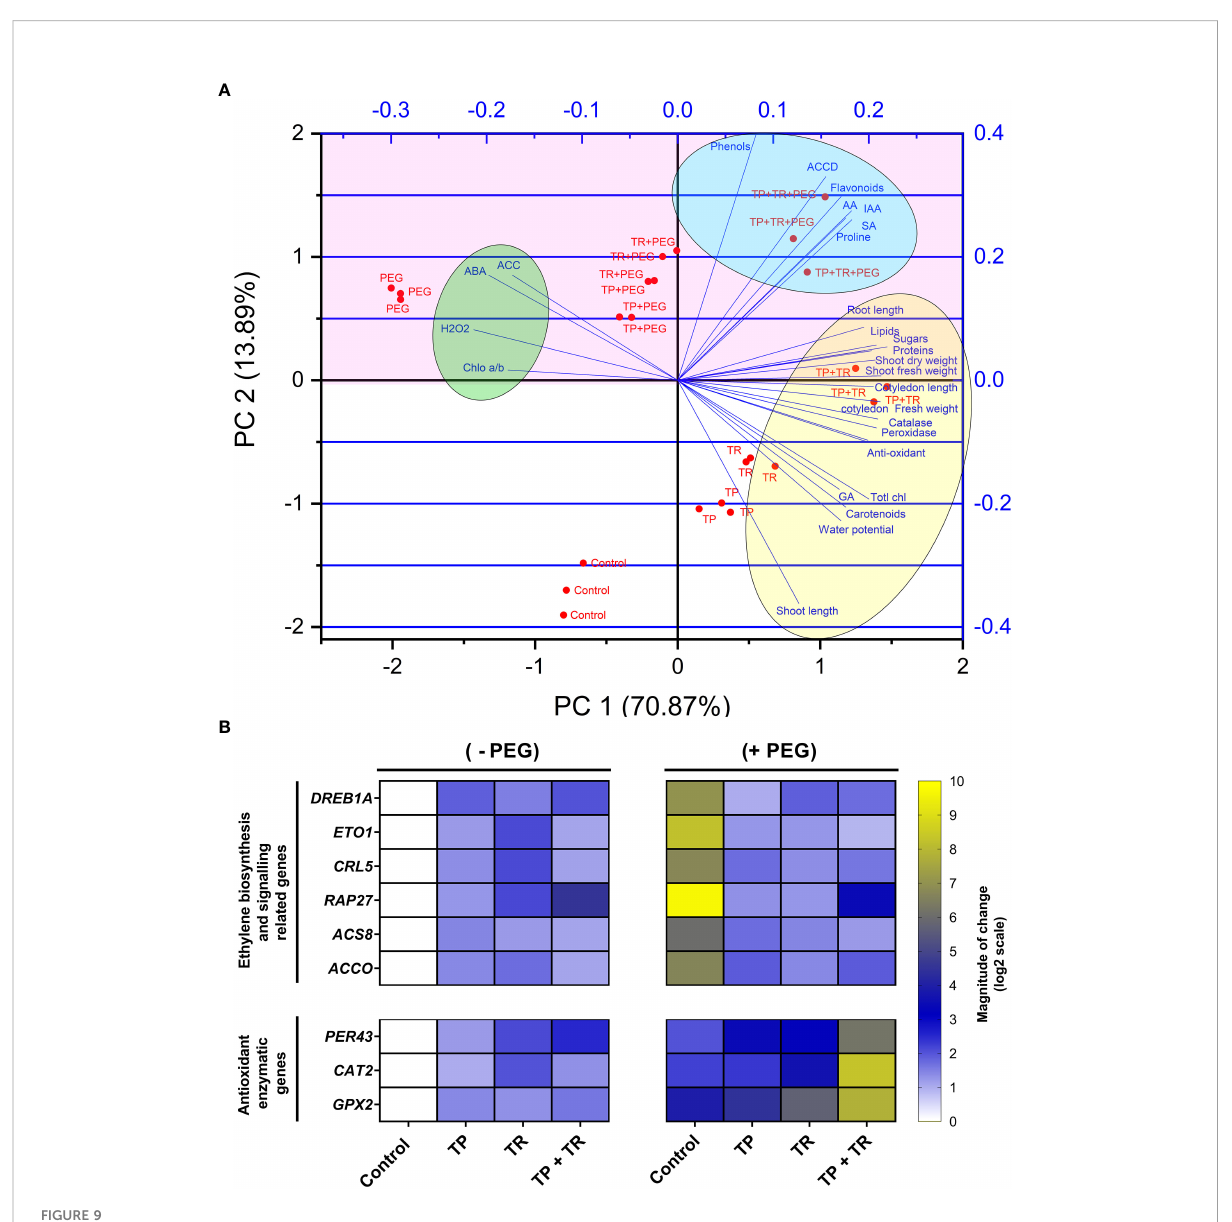
FIGURE 9 (A) Biplot of two dimensions of the principal component analysis (PCA). The scores show the contribution of TP and TR endophytic fungal isolates on reshuf fl ing of M. oleifera plant traits, grown under normal and PEG-supplemented conditions, as indicated by the direction and magnitude of the respective vectors, and (B) Expression pro fi ling of ethylene biosynthesis and antioxidant enzymatic genes by RT-qPCR. Quantitative data represent the means ± SD of three independent experiments and at least three technical replicates